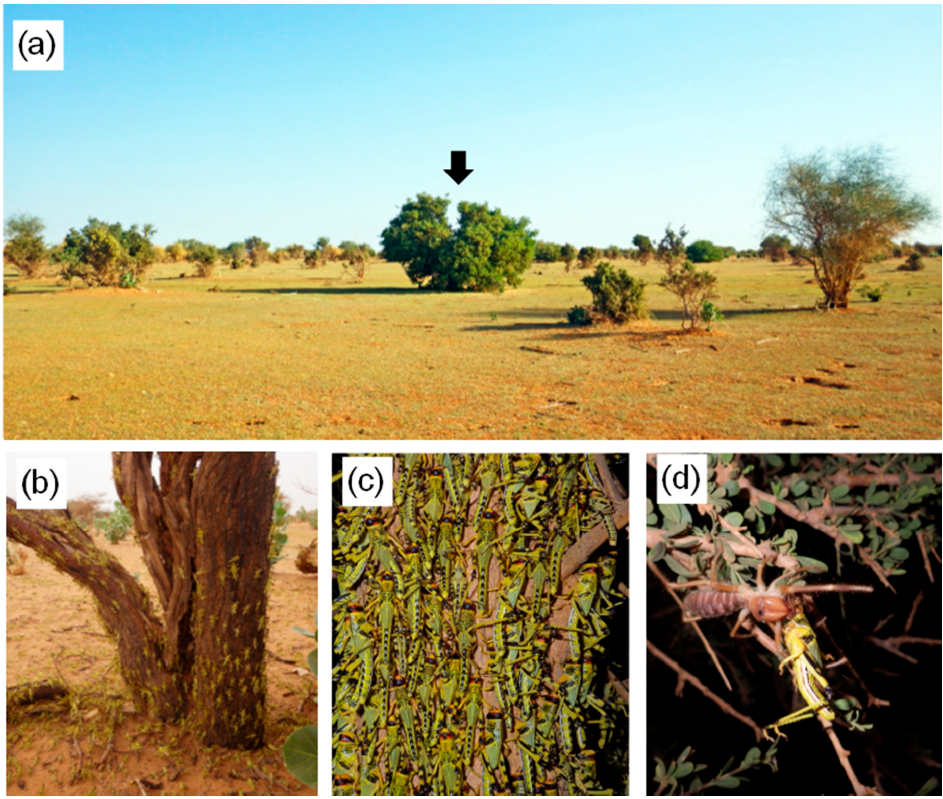
Figure 1. ( a ) Plant community used as a night-roosting site by gregarious nymphs of Schistocerca gregaria . Arrow indicates the largest tree roosted on by the largest locust group in the survey area. ( b ) Marched gregarious nymphs started climbing on a night-roosting tree around dusk. ( c ) Aggregation of gregarious nymphs on a night-roosting plant. ( d ) A camel spider (Solifugae) feeding on a S. gregaria nymph on the roosting plant.